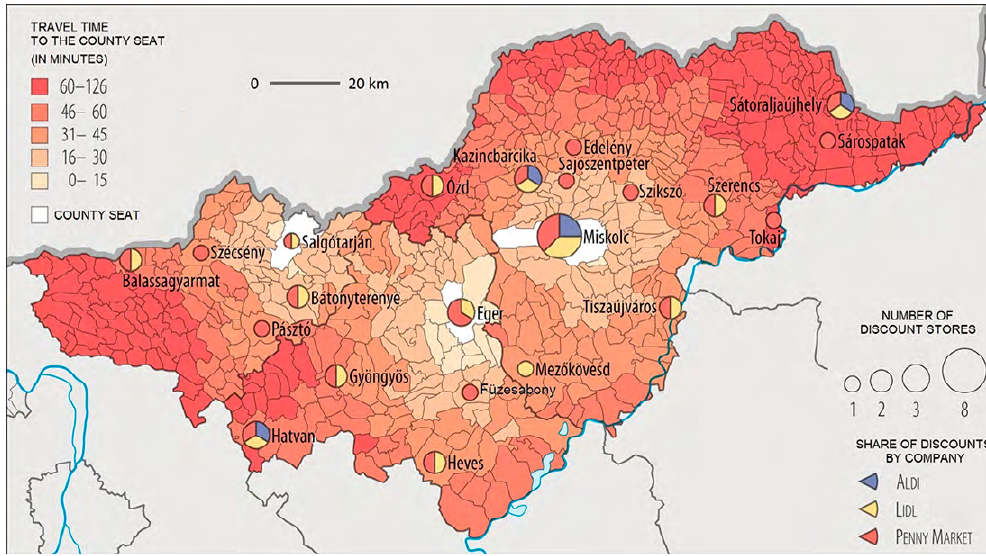
Figure 3. Accessibility and distribution of discounter stores, 2022 Source: own research, drawn by Fanni